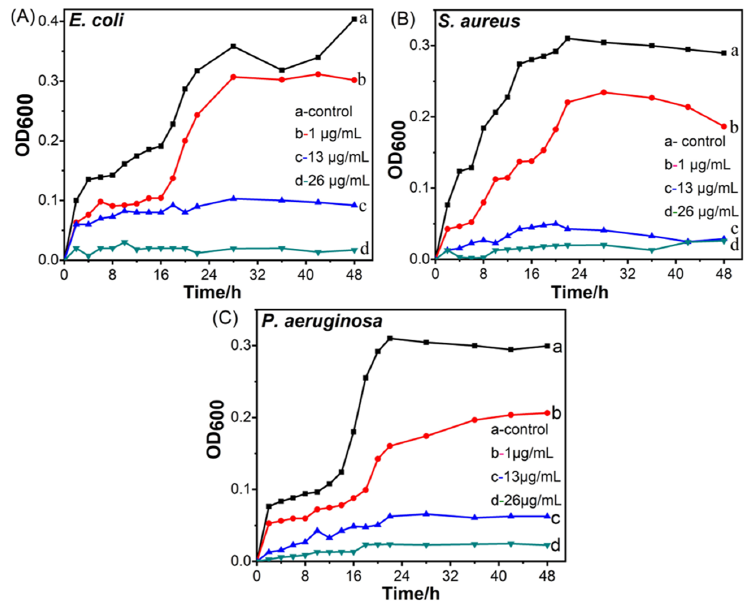
Figure 6. Growth curves of E. coli ( A ), S. aureus ( B ), and P. aeruginosa ( C ) treated with different concentrations of CuO@Ag nanosheets ( b – d ) and normal bacterial as control test ( a ).